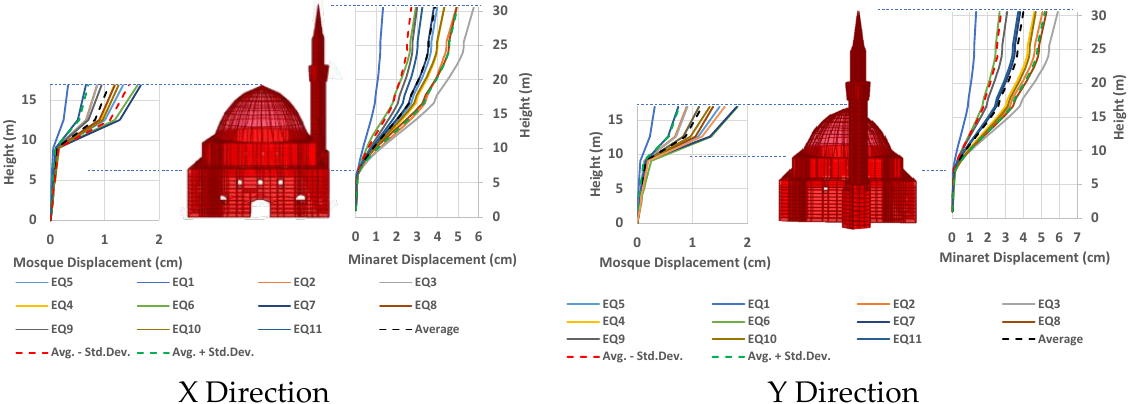
Figure 8. Mosque and minaret displacements for the fixed-base case.